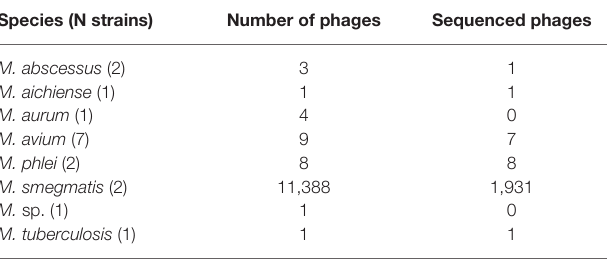
TABLE 1 | Registered phages infecting Mycobacterium genus. Species (N strains) Number of